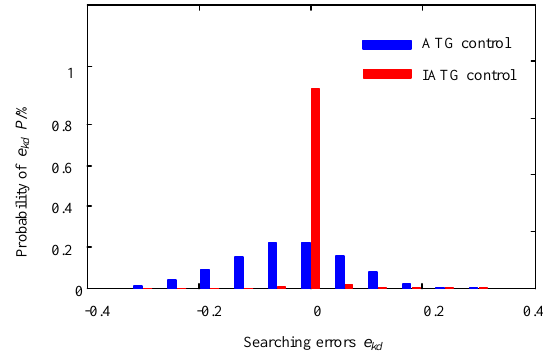
Figure 14. Distribution of the searching errors.